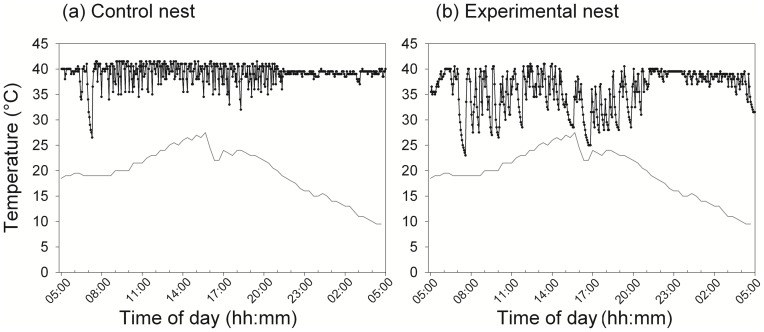
Daily temperature data.Exemplars of one full day (24 hours) of temperature data in (a) control and (b) experimental nests, beginning just before first light. Drops in temperature correspond to the female leaving the nest between bouts of incubation. Ambient temperature shown in gray line. Control and experimental nests were paired for location and date.